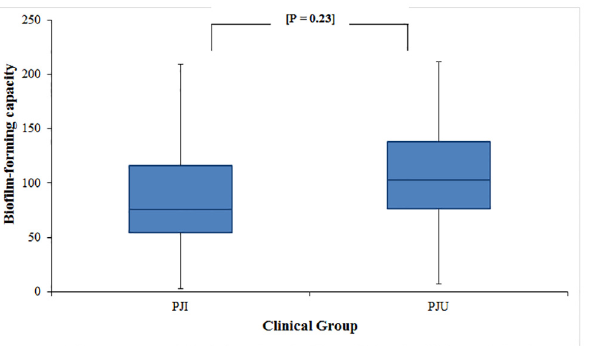
Fig 5. Comparison of the biofilm-forming capacity of S . aureus isolates from prosthetic joint infection (PJI) and uninfected prosthetic joint (PJU) groups. Values were calculated as percentage capacity to form biofilms relative to S . aureus control strain UAMS-1. Box ends represent the 25 th and 75 th percentiles, and whisker ends represent the minimum and maximum. There was no difference in biofilm-forming capacity between isolates in the PJI and PJU